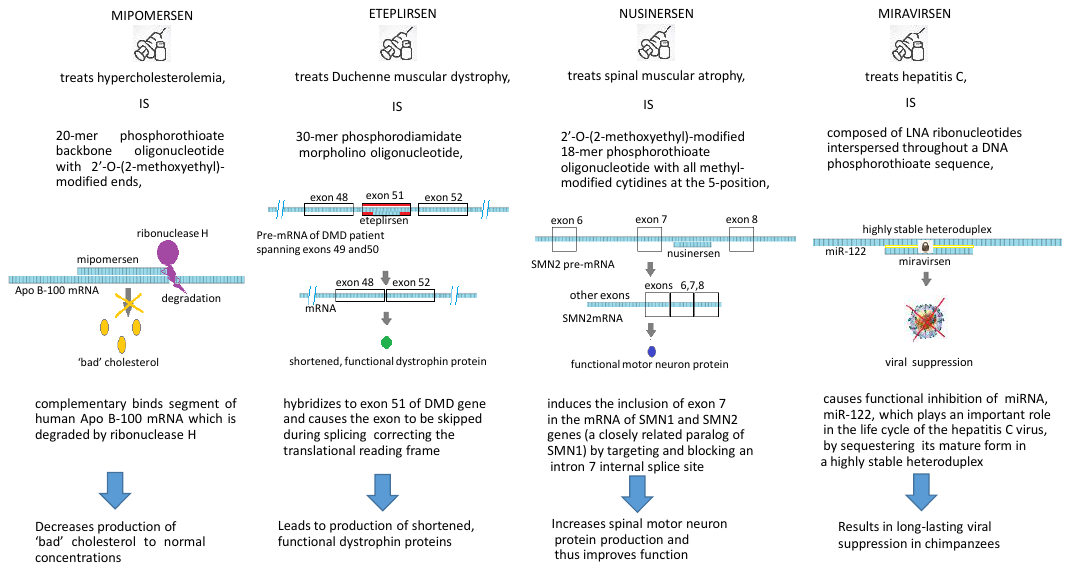
Figure 2. The scheme of action mipomirsen, nusinersen, eteplirsen, and miravirsen.